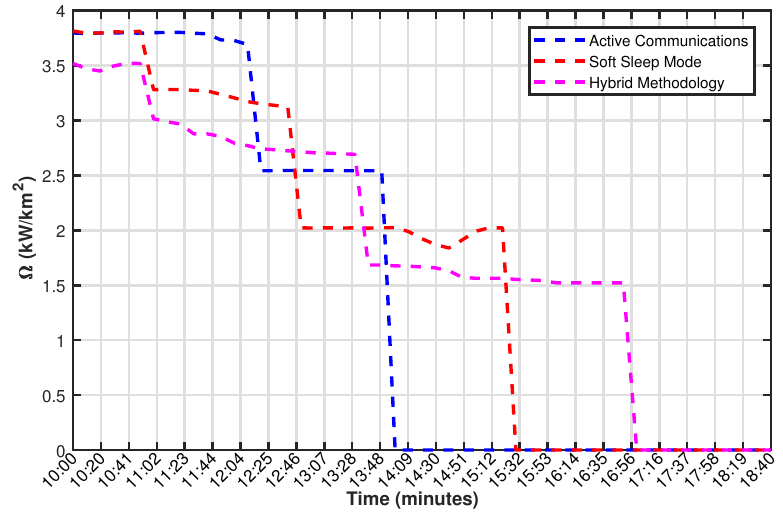
Figure 4. Overall energy efficiency.